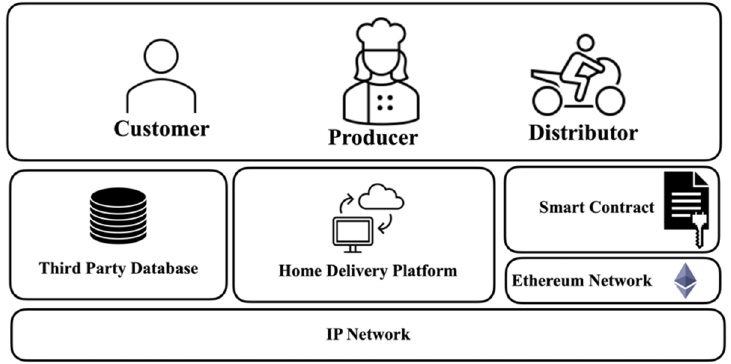
Figure 3. The proposed architecture enhances security by adding the smart contract and the Ethereum Network. All services are communicated over the secured IP